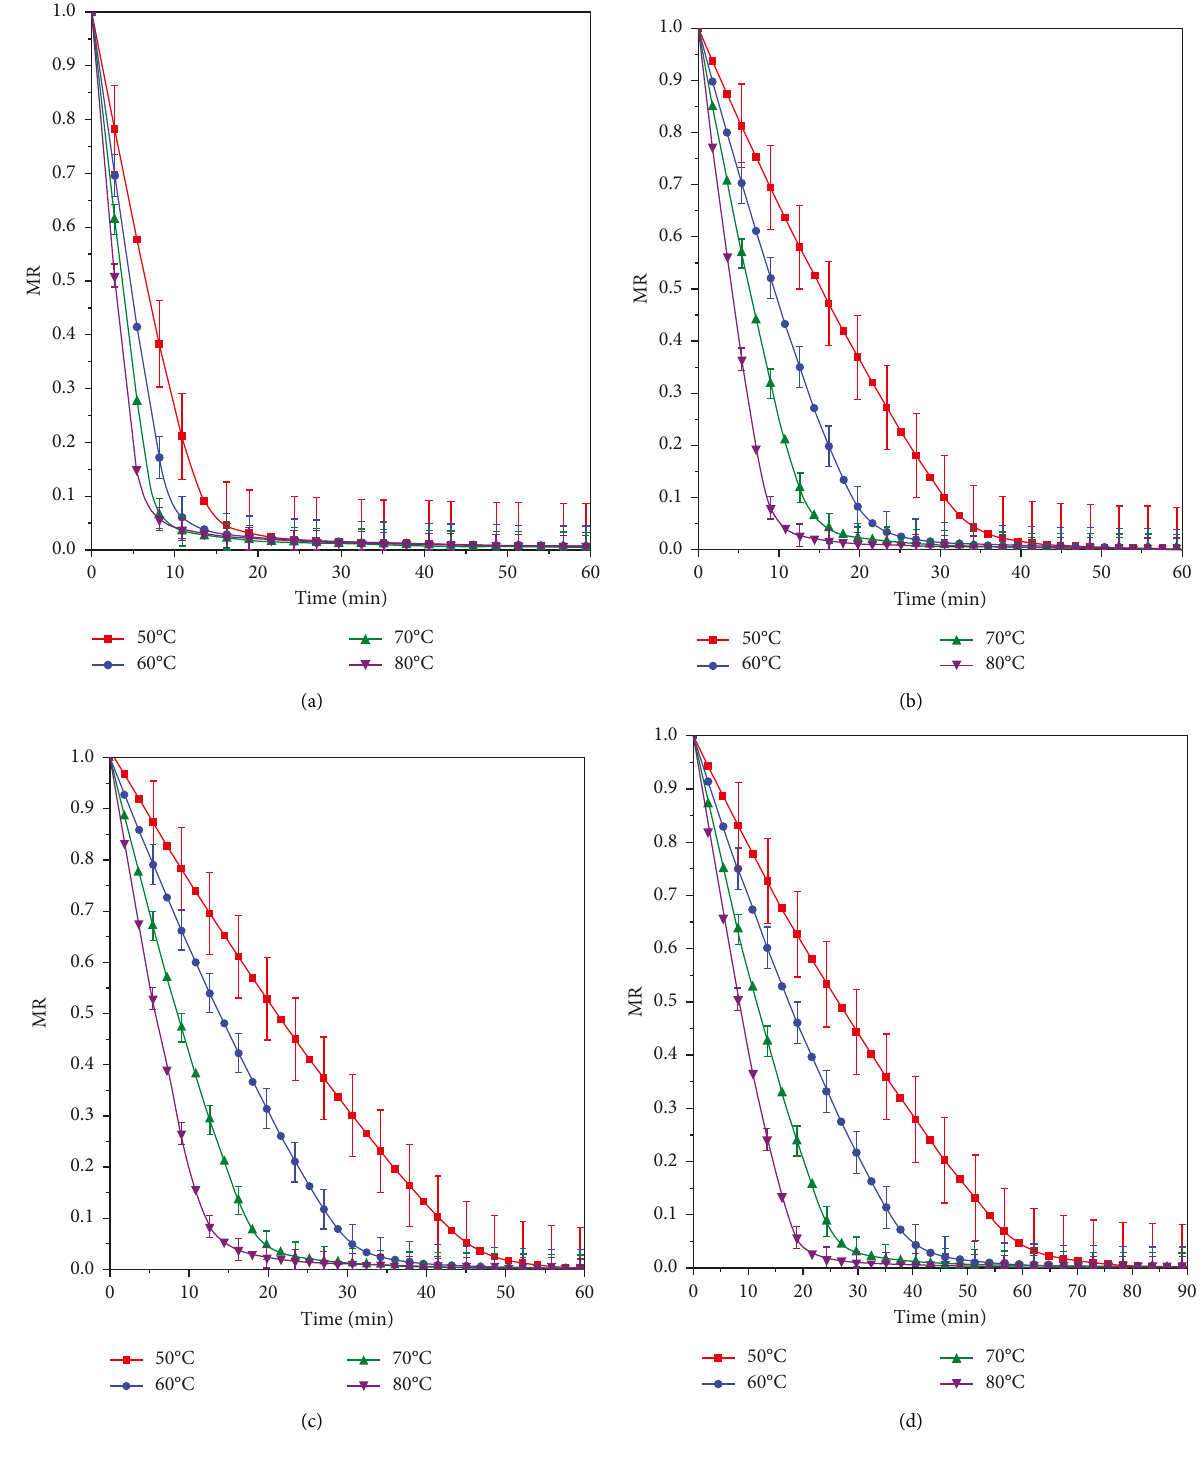
Figure 2: Drying curves (material moisture–drying time): (a) 0.6mm; (b) 1.2mm, (c) 1.8, and (d)